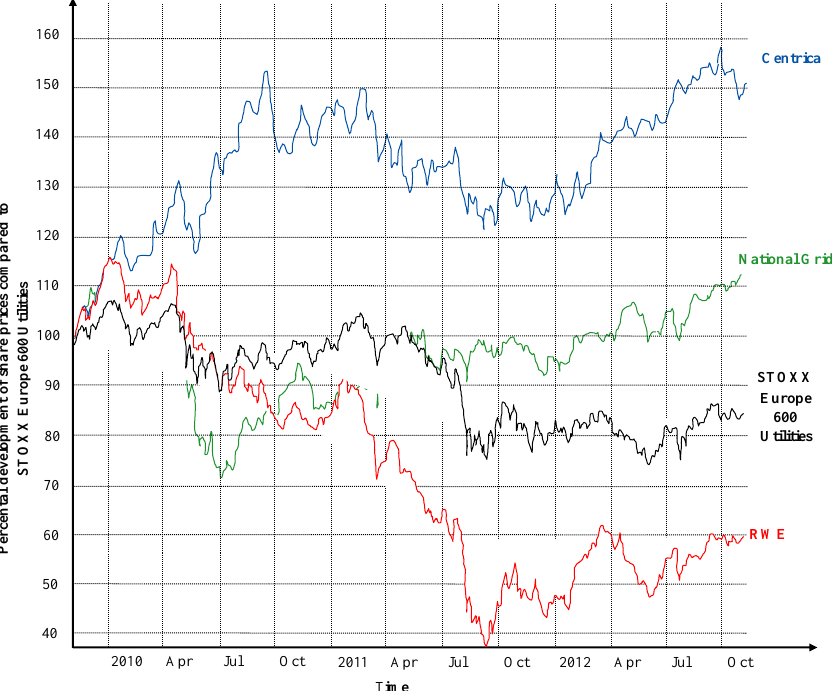
Figure 9. Overview of the relative development of the share prices of selected utilities compared to STOXX ® Europe 600 utilities from October 2009 to October 2012. Own illustration, based on [30].